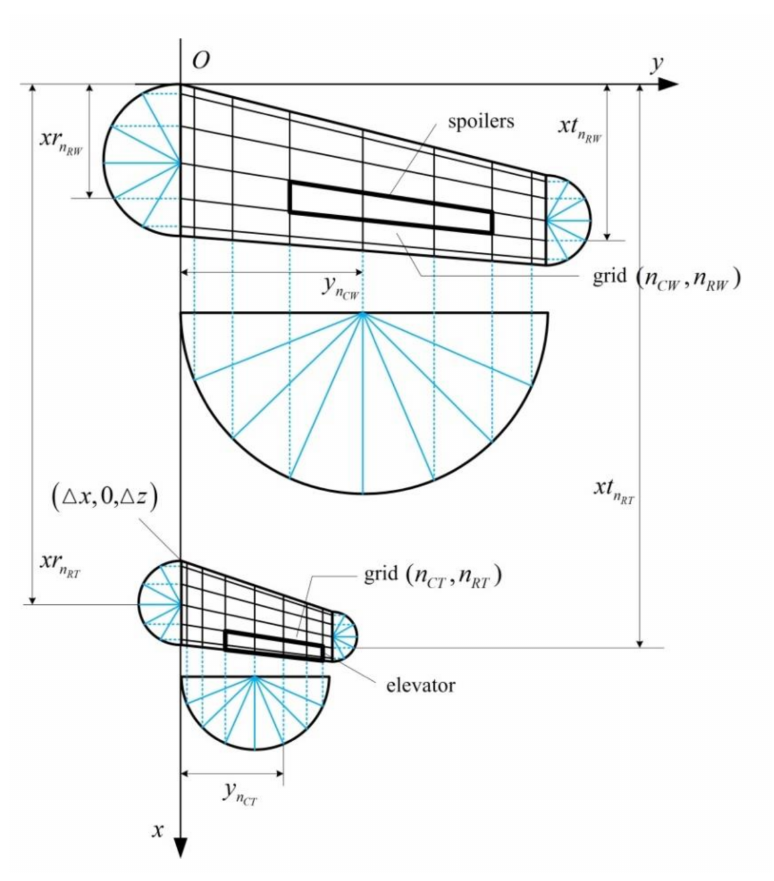
Figure 2. Grid design on the wing-tail